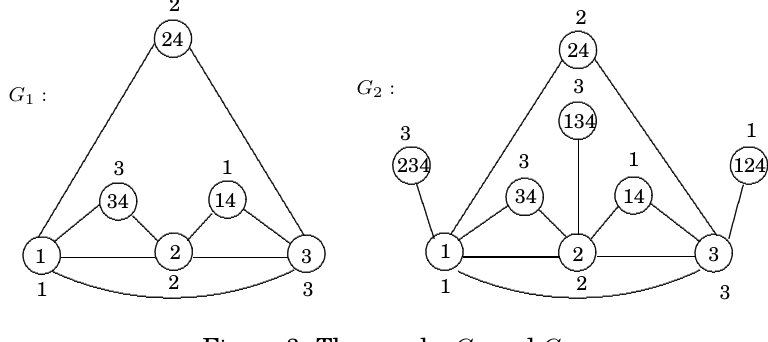
Figure 3: The graphs G